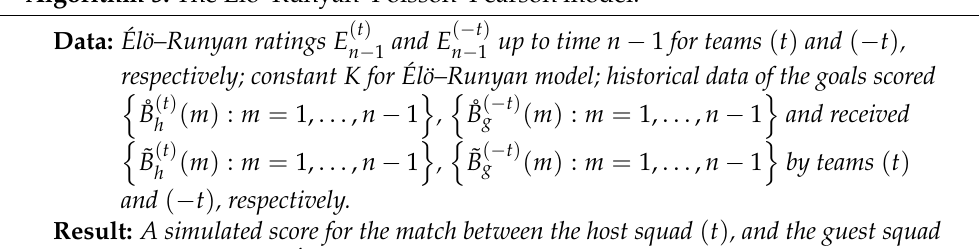
Algorithm 5: The Élö–Runyan–Poisson–Pearson